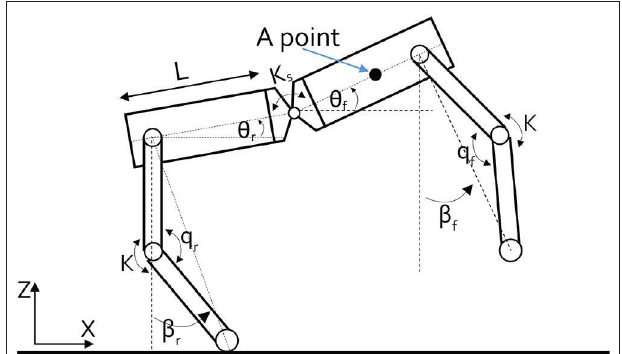
FIGURE 1 | Robot planar model.